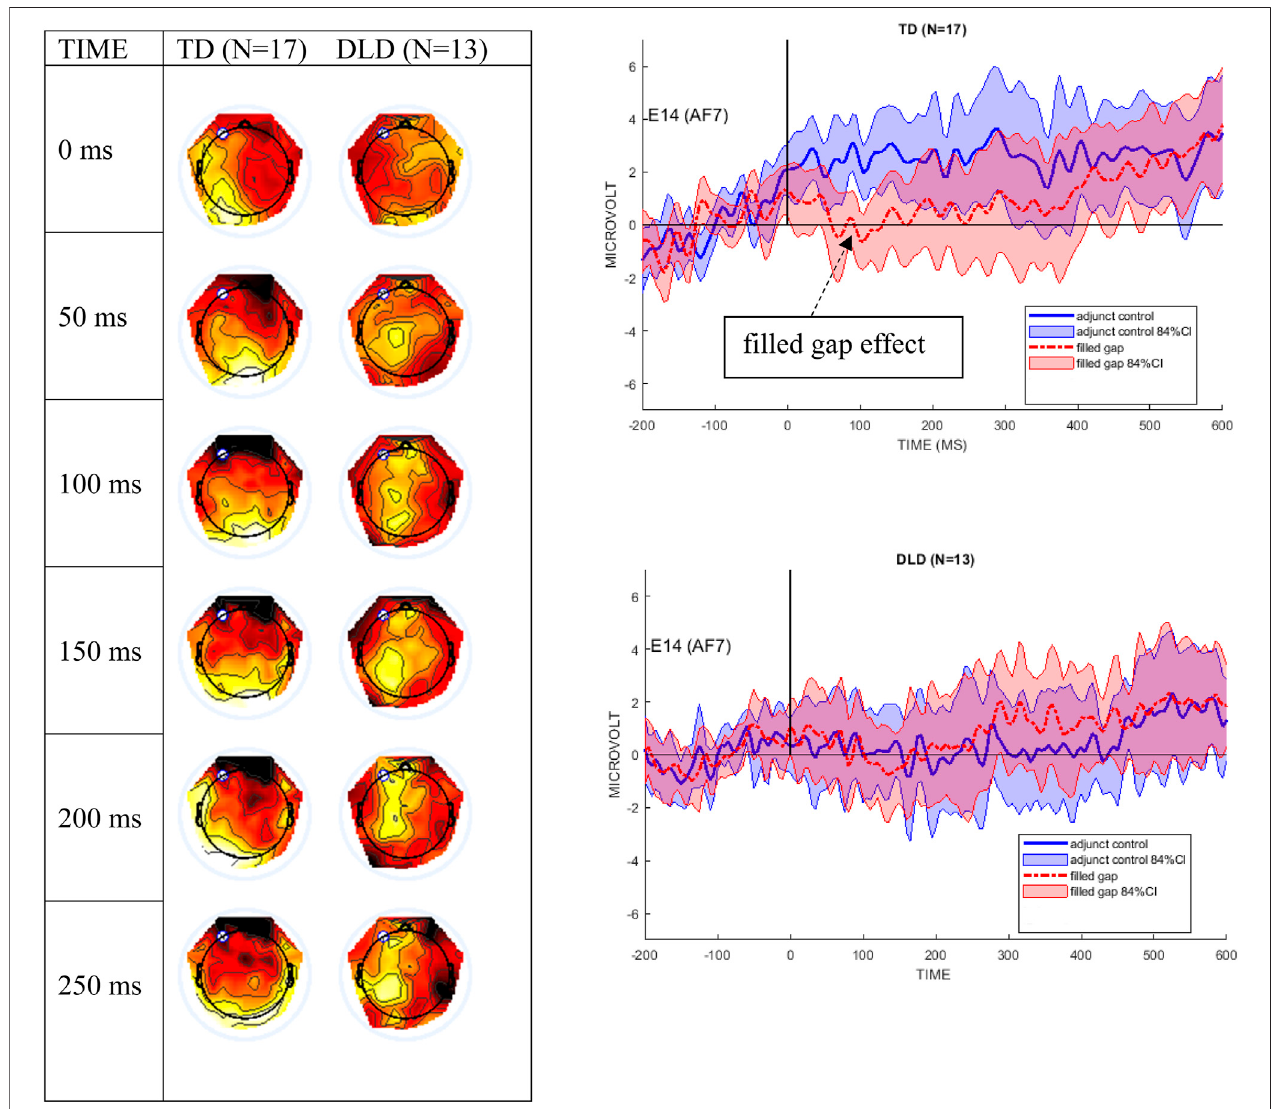
FIGURE4| Theleftpanelshowsdifferencewavetopographicalplotsat50-msincrementsfromonsetofthe fi lledgapNP,fortheTDandtheDLDgroups.Scalefor color min/max: − 2 μ V (dark red) to +2 μ V (white). The white dot is electrode E14 (AF7). The right panel shows electrode E14 for the TD and the DLD group, with 84% con fi dence interval bands around the fi lled gap vs. the adjunct control waves. We here follow authors who argue that 95% CIs are too conservative for ERP designs (Schenker and Gentleman, 2001; Payton et al., 2003; Dien, 2020).